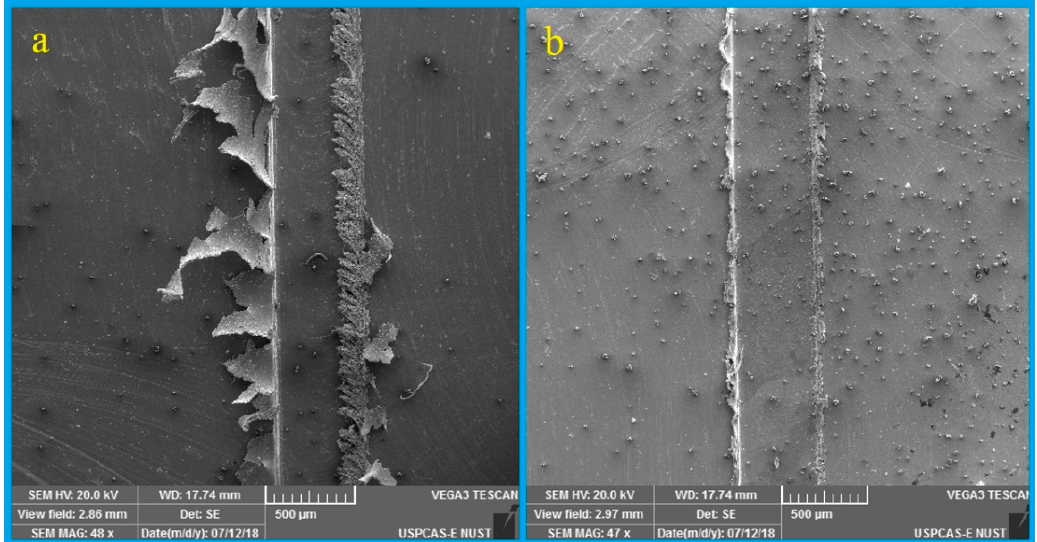
Figure 9. SEM images for confirmation experiments showing: ( a ) severe burr formation for worst cutting conditions ( a P = 30 µm, V C = 12 m/min, f Z = 0.6 µm/tooth); ( b ) minor burr formation at optimum cutting conditions ( a P = 90 µm, V C = 8 m/min, f Z = 0.2 µm/tooth).